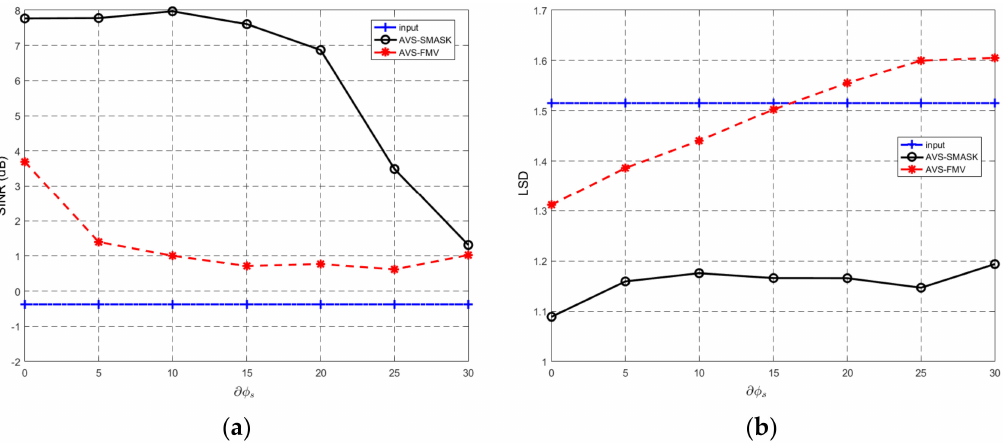
Figure 8. (Experiment 3) The performance versus the ∂φ s . ( a ) SINR results and ( b ) LSD results (Case